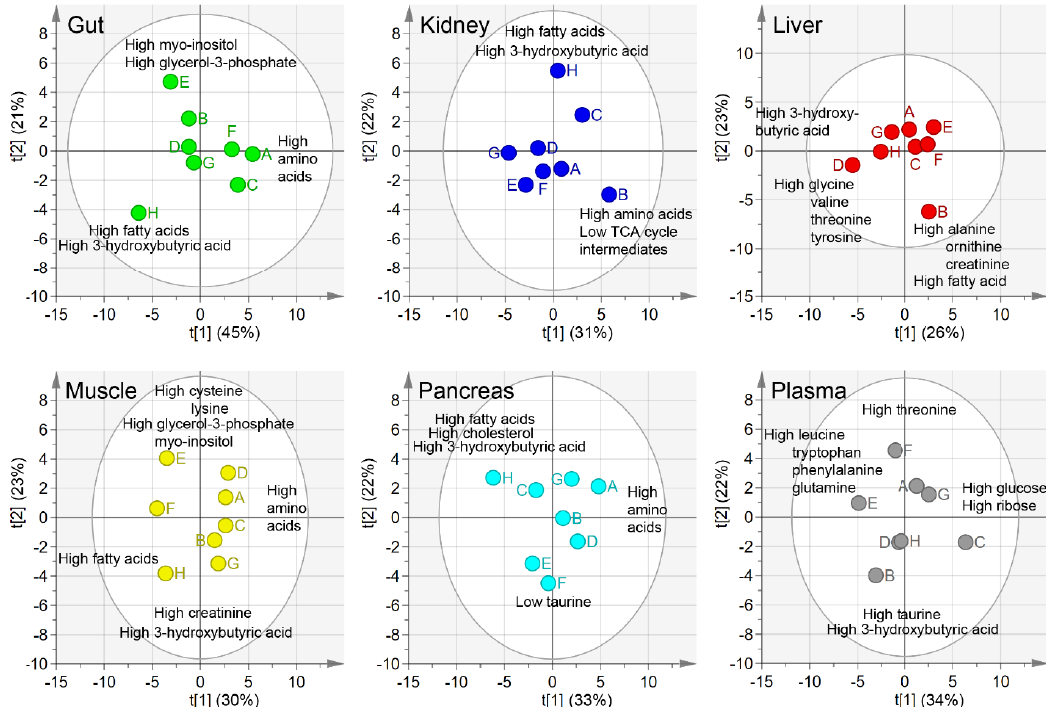
Figure 1. Separate principal component analysis (PCA) score plots for each tissue type. The percentages on the x- and y-axes indicated the amount of variation that was explained by each component. The underlying metabolite trends revealed by the loadings combined with the contribution plot was added as a text in the corresponding regions. Different colors were used for the tissue samples: Gut—green, kidney—blue, liver—red, muscle—yellow, pancreas—turquoise, and grey—plasma.